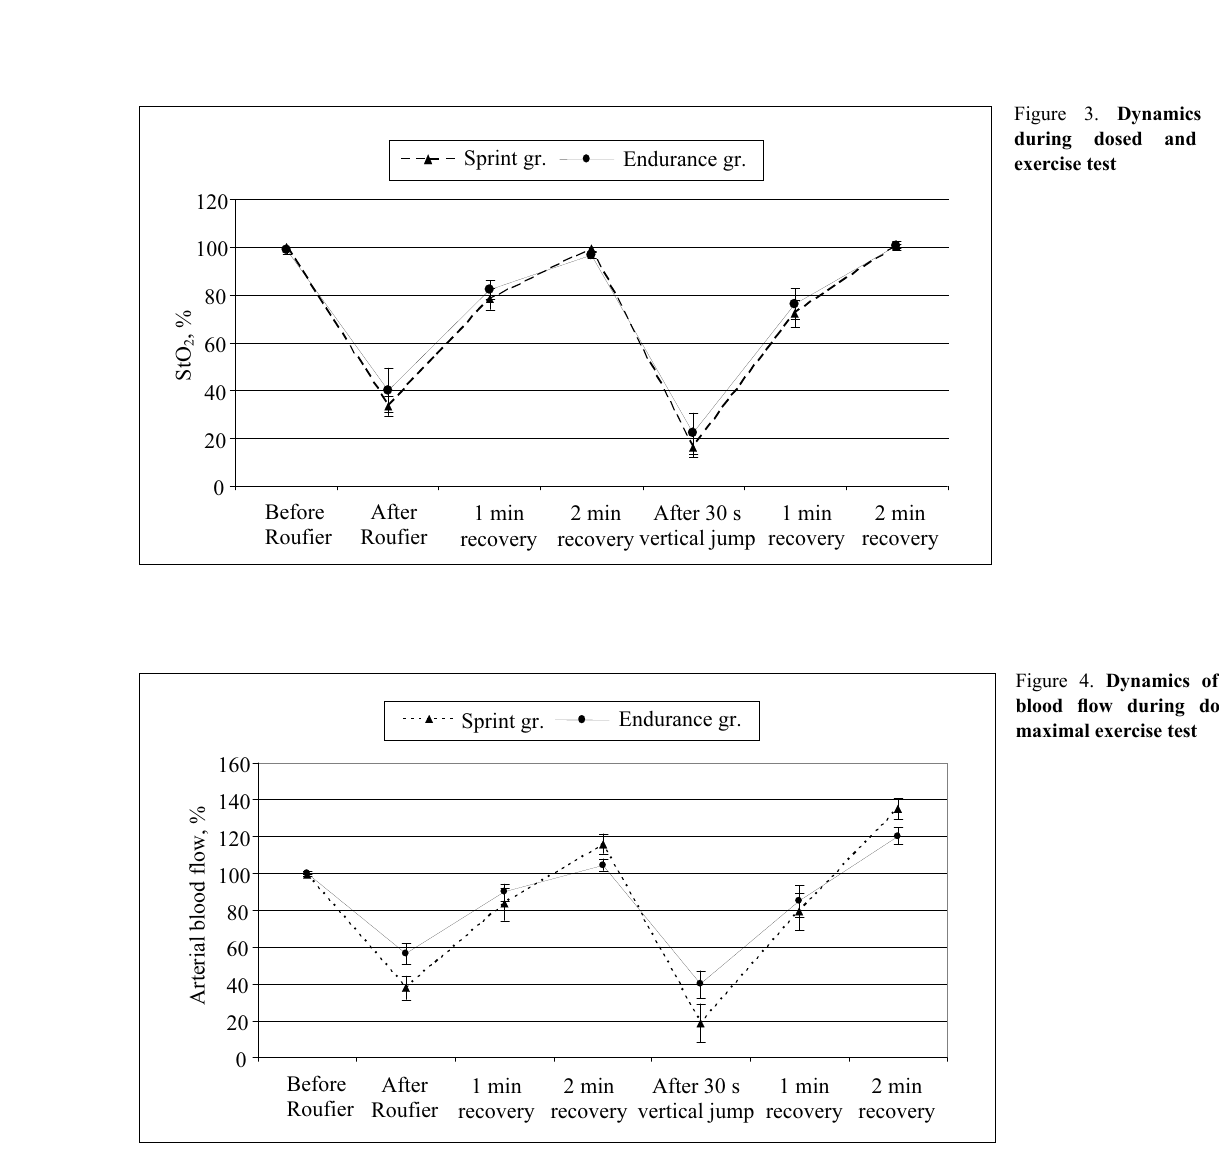
Figure 4. Dynamics of arterial blood flow during dosed and maximal exercise test